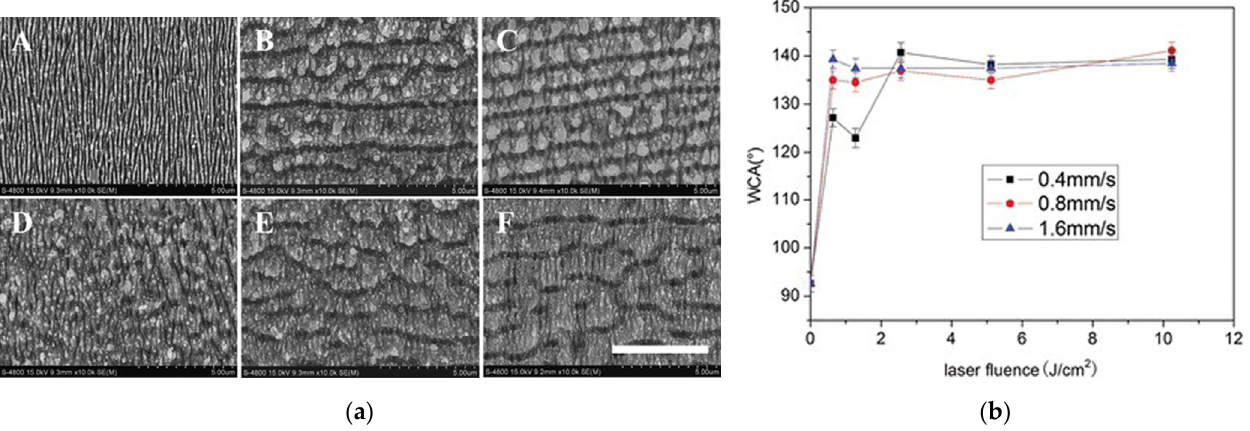
Figure 13. Surface structure and wetting performance of 316L [63]. ( a ) Micropatterns of the stainless steel surfaces induced by femtosecond laser with different laser fluence and scanning speeds in deionized water (scale bar is 5 μ m); ( A ) 0.64 J/cm 2 , 0.4 mm/s; ( B ) 0.64 J/cm 2 , 0.8 mm/s; ( C ) 0.64 J/cm 2 , 1.6 mm/s; ( D ) 1.28 J/cm 2 , 0.4 mm/s; ( E ) 2.56 J/cm 2 , 0.4 mm/s; ( F ) 5.12 J/cm 2 , 0.4 mm/s; ( b ) effect of depth on the contact angles. Reprinted by permission of the publisher (Taylor & Francis Ltd., http://www.tandfonline.com, accessed on 23 January